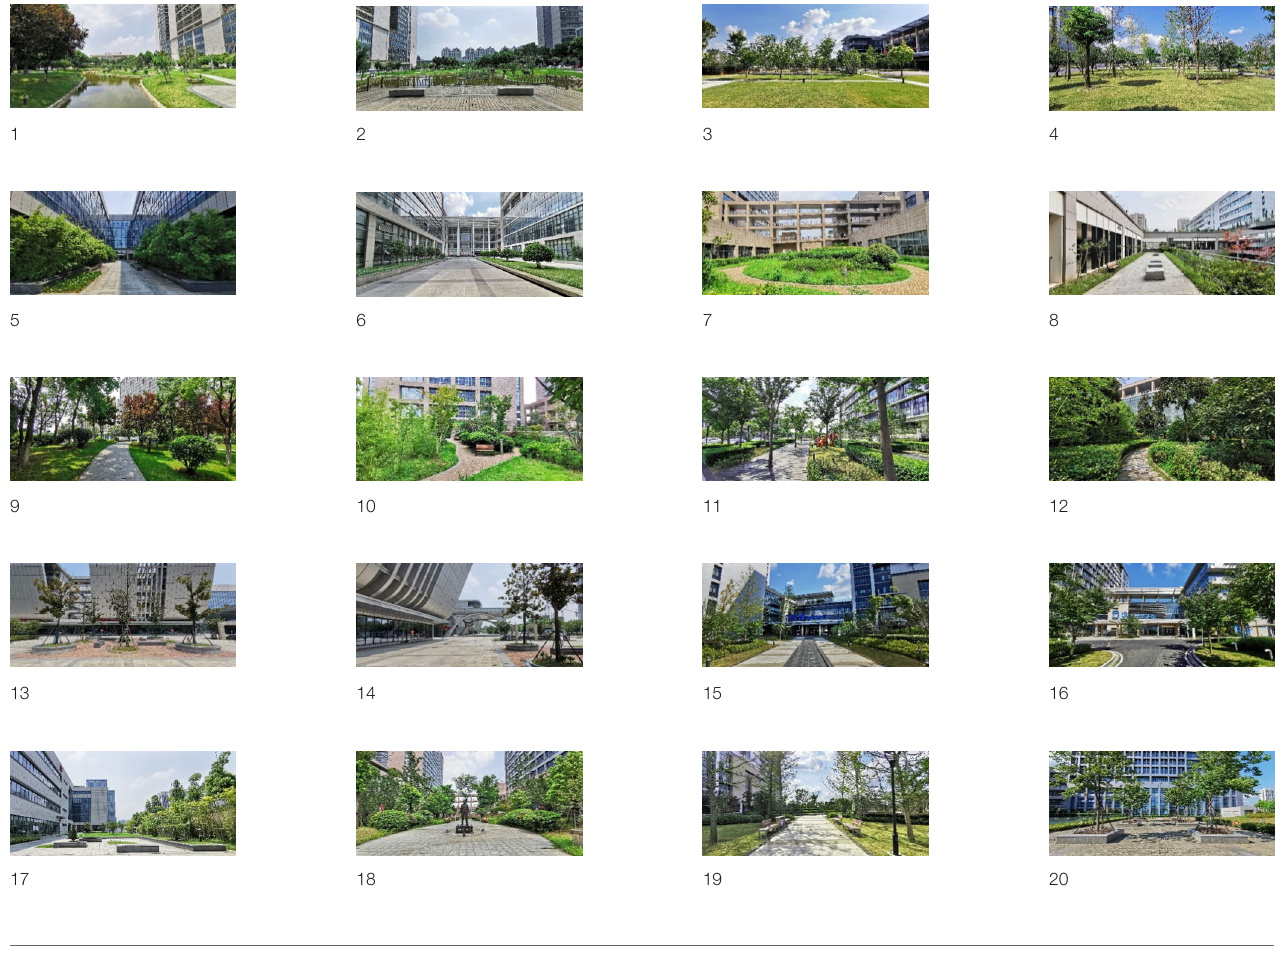
TABLE 1 | 20 Sample pictures used in this research.